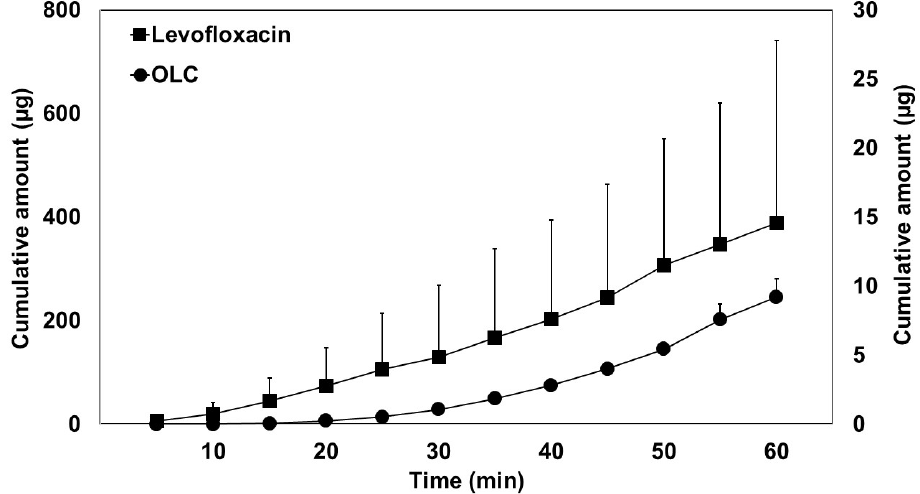
Figure 5. Transport of oleocanthal (OLC) (right Y -axis scale) and levofloxacin (left Y -axis scale) from the intestinal lumen to the mesenteric blood. Cumulative amount values are normalised to a 10-cm intestinal segment. Results are expressed as the mean ± standard deviation.